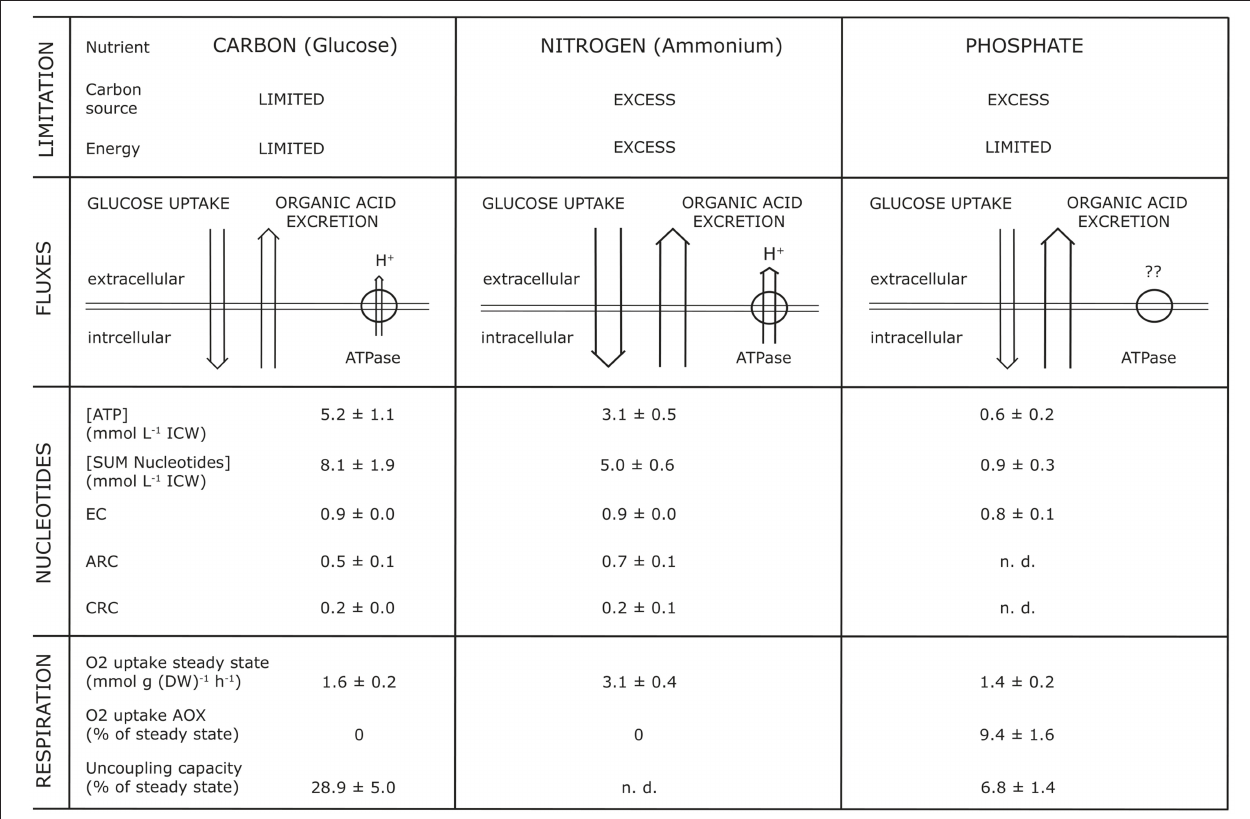
FIGURE 1 | Synopsis of parameters simultaneously analyzed with organic acid excretion at different nutrient limitations (glucose, ammonium, phosphate) during growth of Penicillium ochrochloron CBS 123.824 in chemostat culture at a specific growth rate µ of 0.1 h − 1 . EC, Energy Charge; CRC, Catabolic Reduction Charge; ARC, Anabolic Reduction Charge; n.d., not determinable. The Figure is taken from Figure 7 of Vrabl et al. (2017).